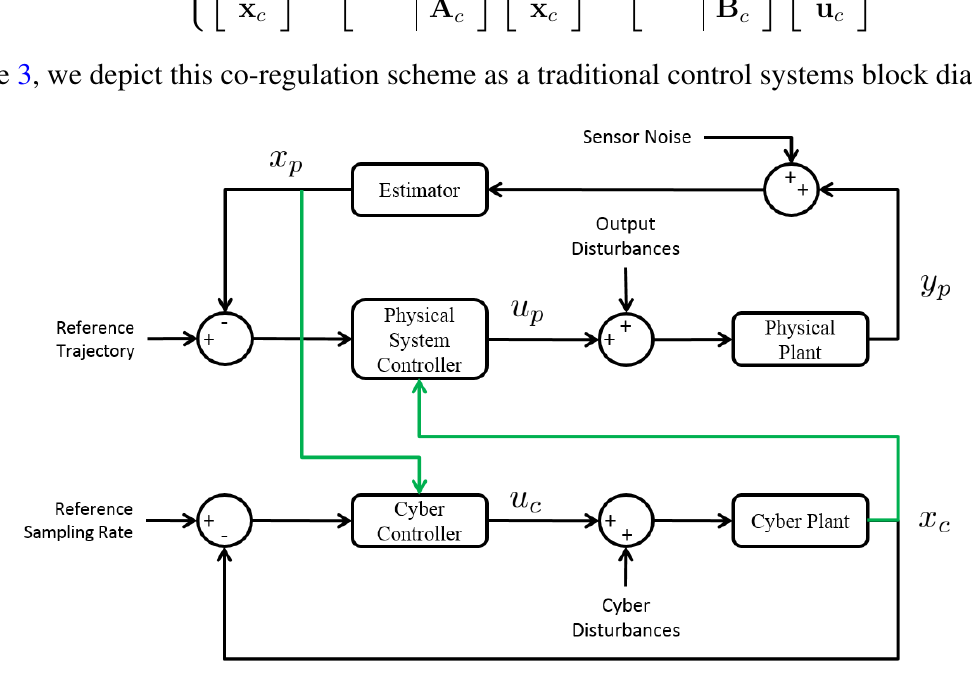
Figure 3. CPVS co-regulation